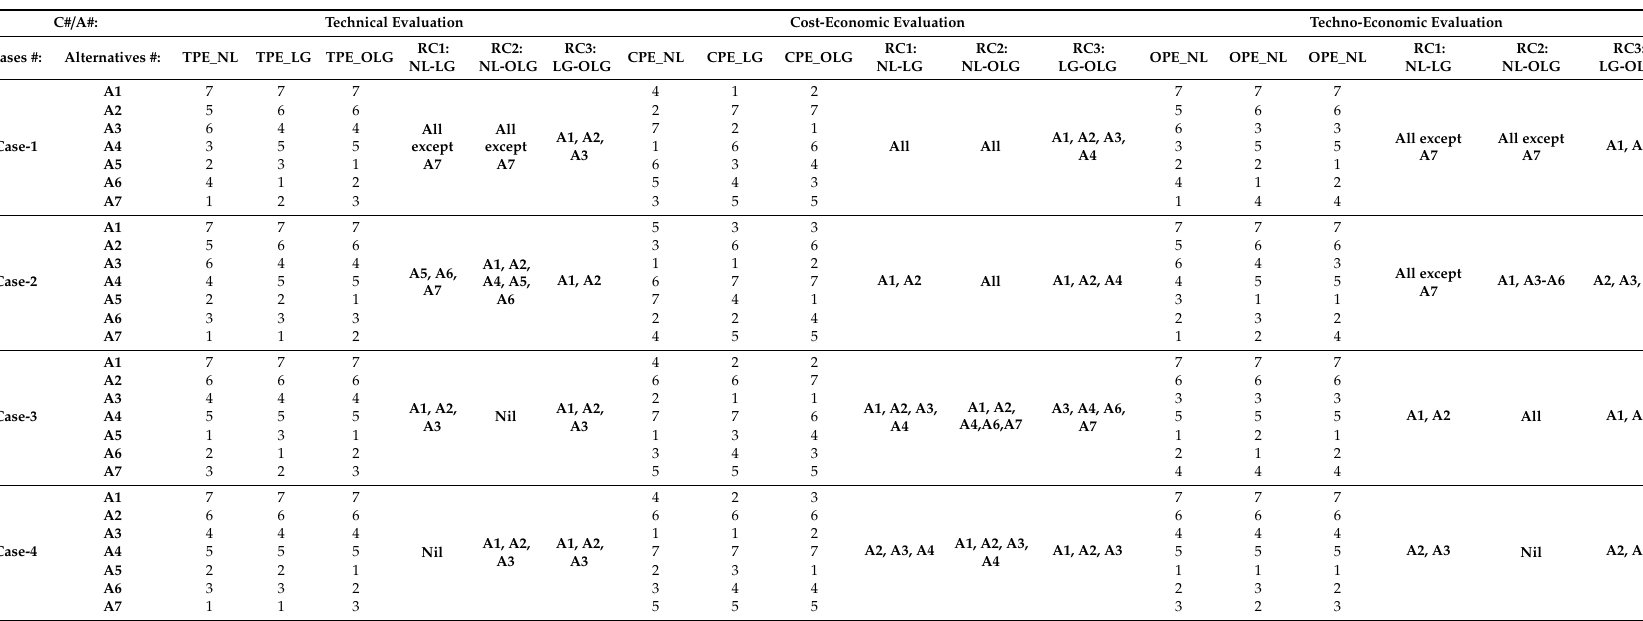
Table 29. Overview performance evaluation analysis for all evaluated cases of IDMP across various evaluations for self-comparison of change in ranks. C# / A#: TechnicalEvaluation Cost-EconomicEvaluation